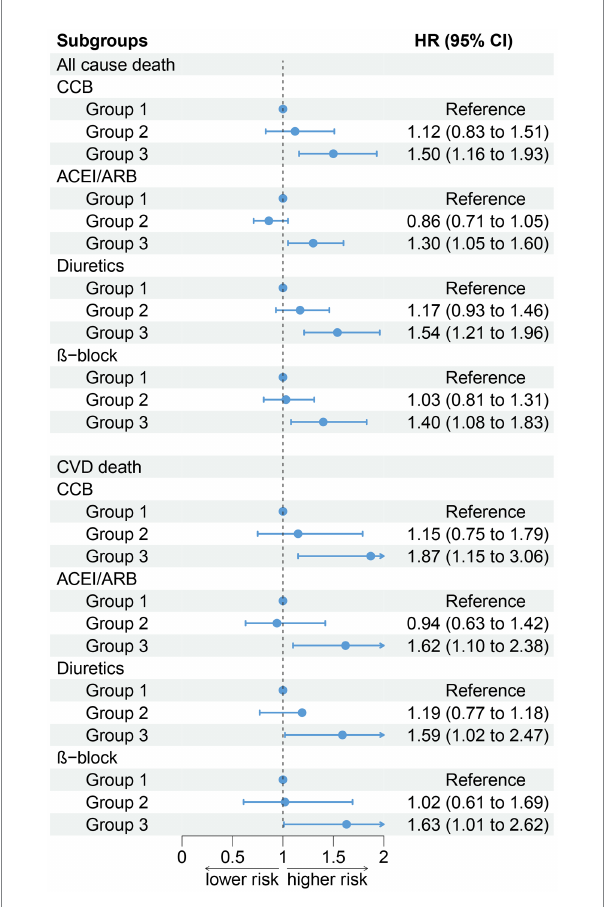
FIGURE 5 Association between PIV and all-cause and CVD mortality by hypotensive drugs stratification (weighted).